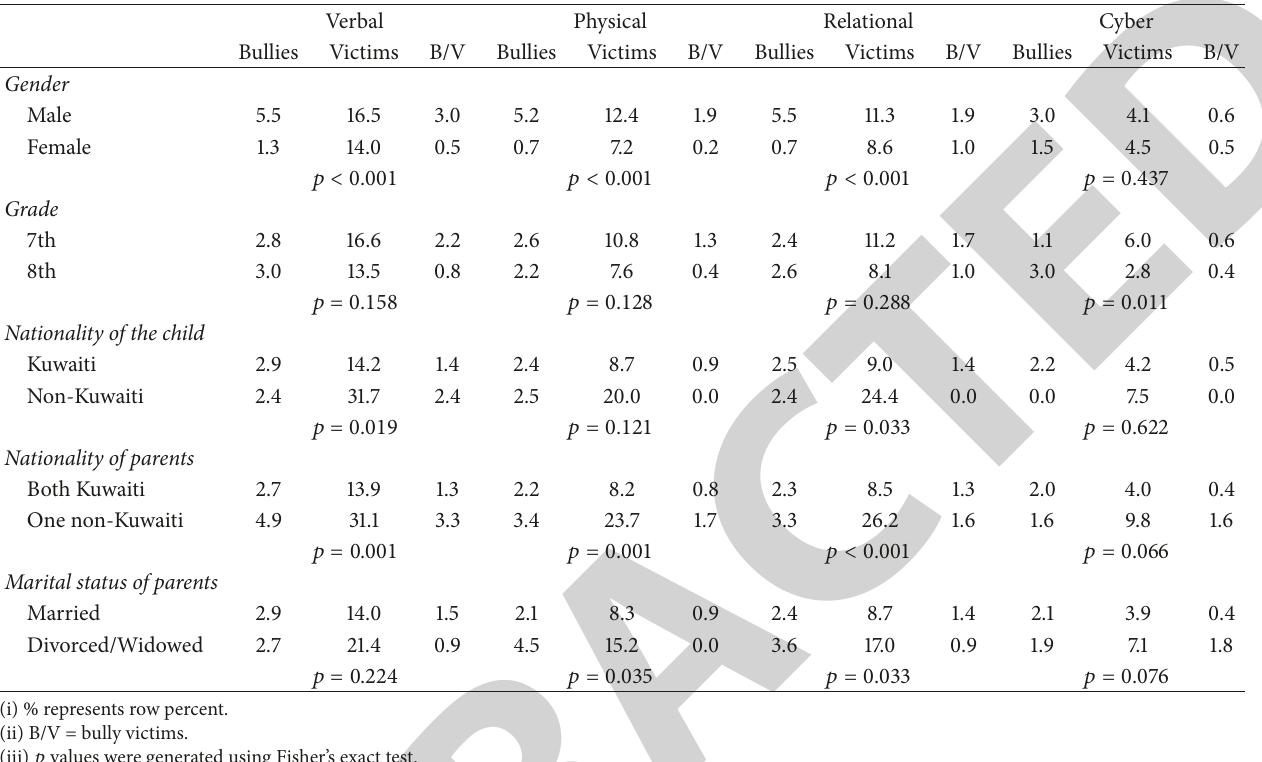
Table 3: Prevalence (%) of bullies, victims, and bully victims within each form of bullying (verbal, physical, relational, and cyber) by sociodemographic characteristics.